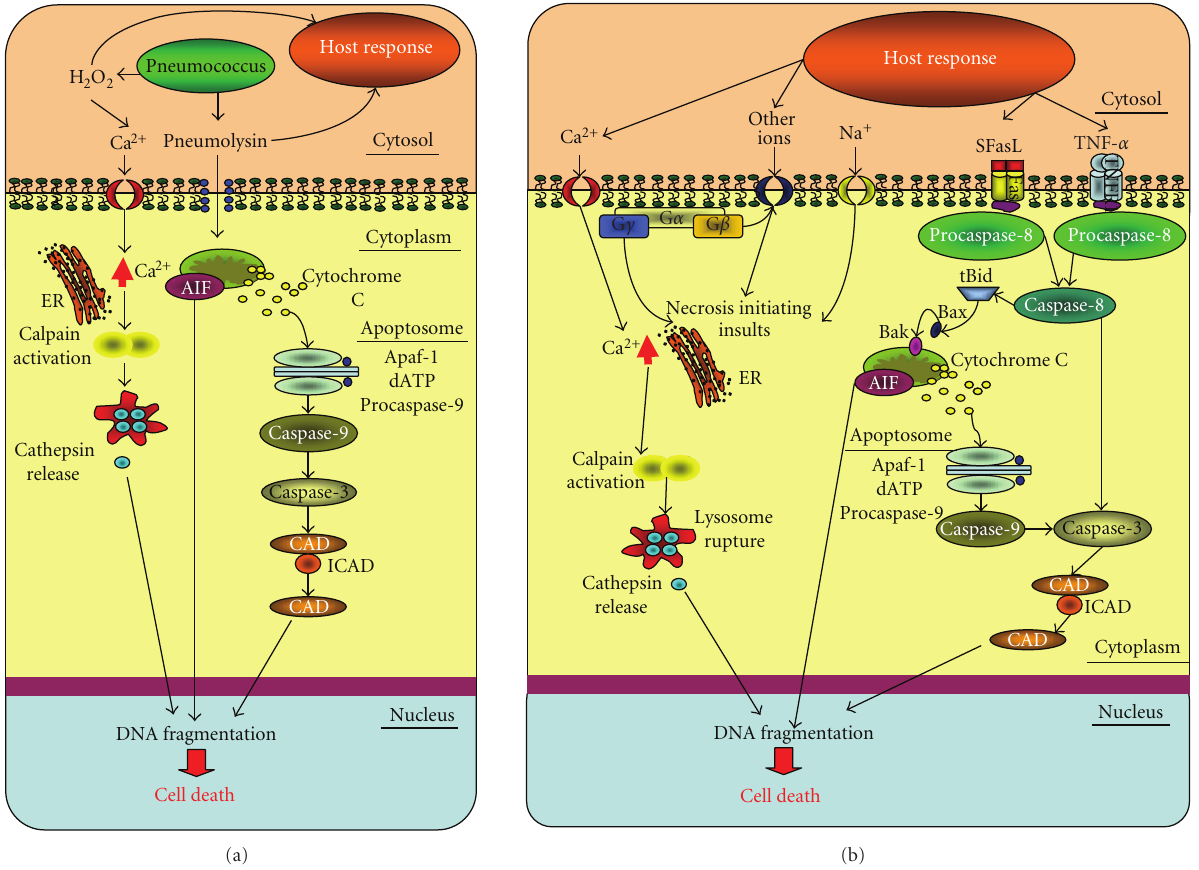
Figure 3: (a) The cell wall of S. pneumoniae has a diverse protein population. Proteins such as pneumolysin can trigger apoptosis on entering cells by destruction of the mitochondria. In addition oxidising components such as hydrogen peroxide can trigger apoptosis and necrosis. (b) The host immune response will most likely be made up of complement and cytokines which can activate transmembrane death receptors such as Fas. This will cause receptors to aggregate together on the cell surface leading to apoptosis. The adaptor protein Fas-associated death domain protein (FADD) activates caspase-8, an initiator protein, to form a signal complex to directly activate caspase-3. Active caspase-8 can also cleave BID protein to tBID, which acts as a signal on the membrane of mitochondria to facilitate the release of cytochrome c in the intrinsic pathway. The mitochondrial stress pathway is initiated when proapoptotic proteins in the cytoplasm, BAX, and BID stimulate the rupture of the mitochondria. The release of mitochondrial content is aided by the protein BAK. In the caspase dependant pathway, cytochrome c released from the mitochondria forms a complex in the cytoplasm with adenosine triphosphate (ATP) and apoptotic protease activating factor-1 (Apaf-1). This complex activates caspase-9, an initiator protein. In return, the activated caspase-9 works together with the complex of cytochrome c, ATP, and Apaf-1 to form an apoptosome, which in turn activates caspase-3, the e ff ector protein that initiates degradation. The caspase independent pathway (pyknosis) is as a result of apoptosis inducing factor (AIF). The necrotic pathway is activated in severe meningitis. Alterations in the concentration of cytoplasmic calcium could signal the mobilisation of executioner cathepsin proteases and other hydrolases, through calpain activation. Calpains have been implicated in the activation of proapoptotic caspase proteases; hence the later steps of necrosis correlate with the later steps of